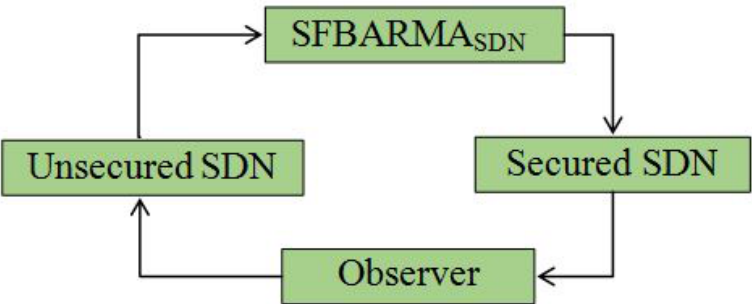
Figure 1. Block diagram for the feedback control system for the SFBARMA SDN